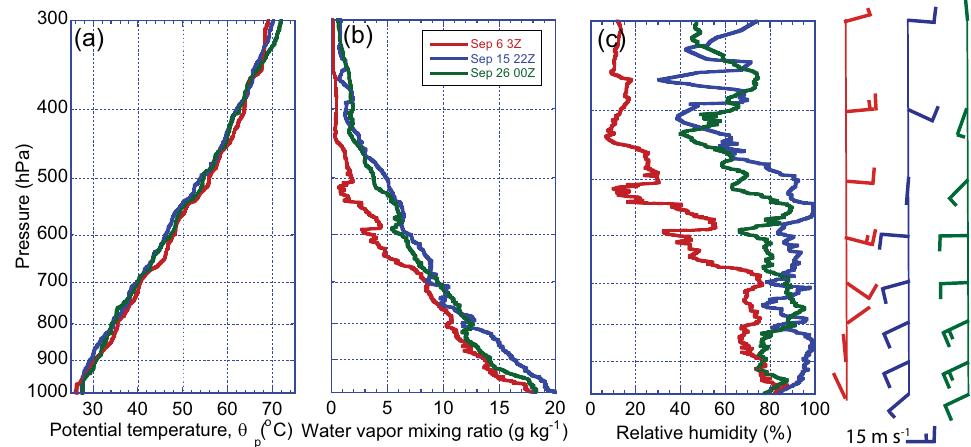
Figure 6. Sounding profiles of (a) potential temperature, (b) water vapor mixing ratio, and (c) relative humidity for profiles corresponding to the nucleation event on 6 September at Apo Reef and the biomass burning cases of 15 and 26 September at Balabac Island and Tubbataha Reef, respectively. Wind flags for these cases are marked on the far